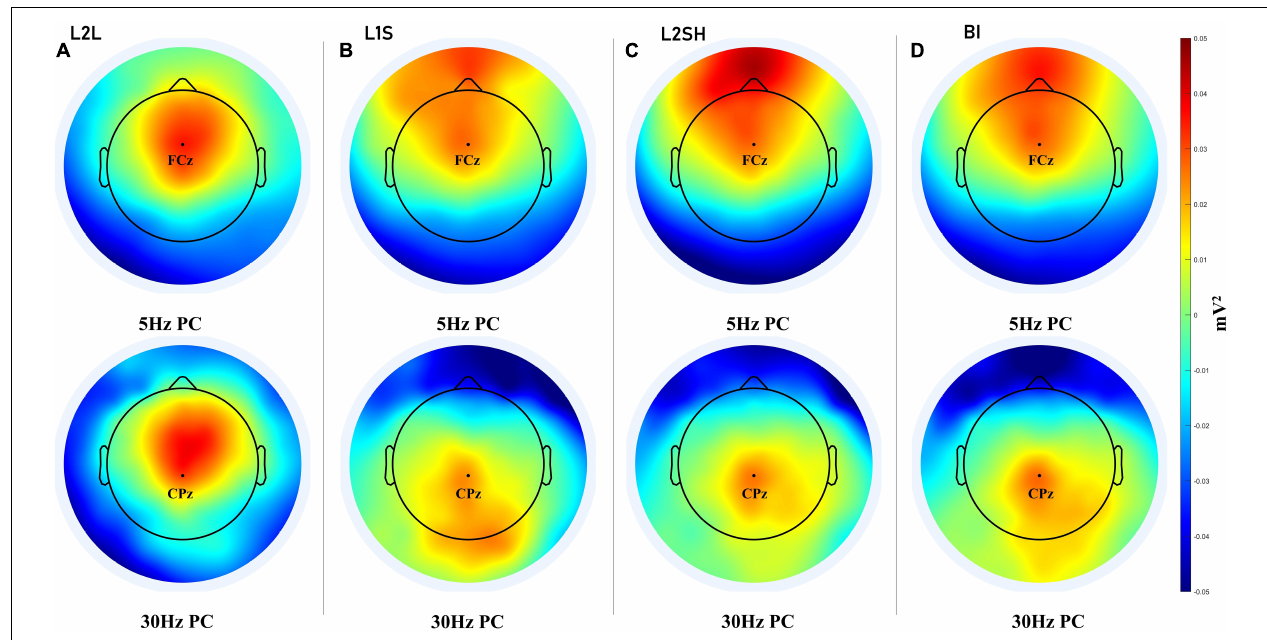
FIGURE 4 | PCA results for all language tasks. (A) PC for 5 and 30 Hz in L2L. (B) PC for 5 and 30 Hz in L1S. (C) PC for 5 and 30 Hz in L2SH. (D) PC for 5 and 30 Hz in BI. For each panel channel FCz and channel CPz are marked for the convenience of